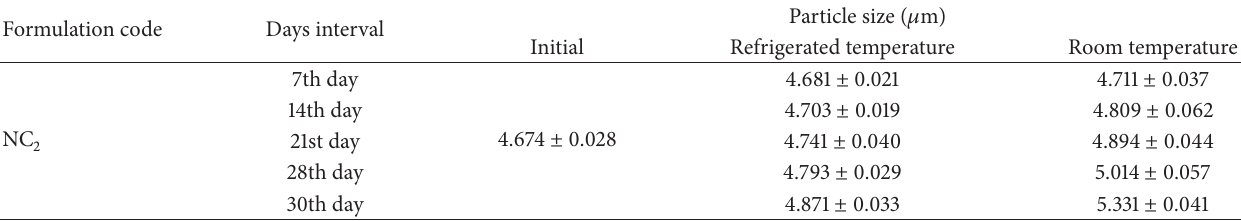
Table 4: Effect of storage on particle size at refrigerated and room temperature.